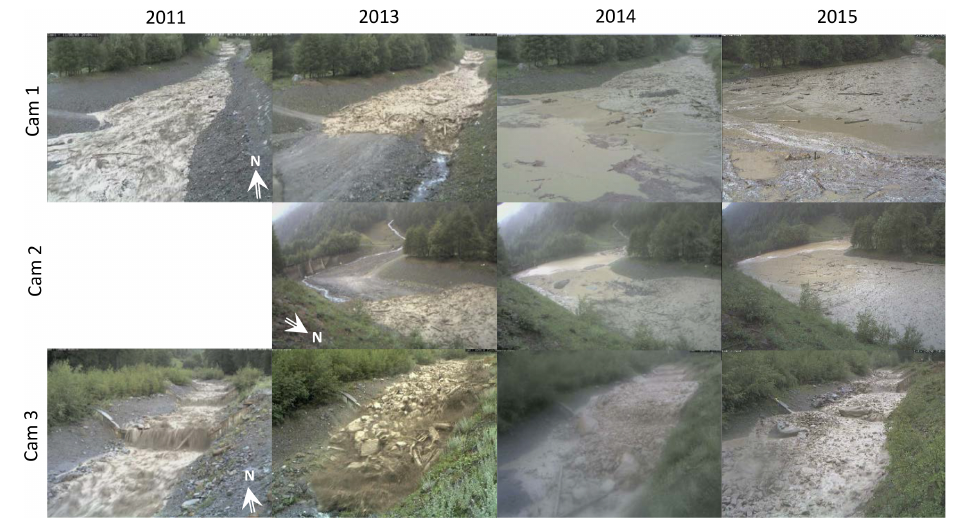
Figure 3. Views of the three cameras during the 2011, 2013, 2014, and 2015 debris flows. Cam 2 was selected for the LSPIV application due to best